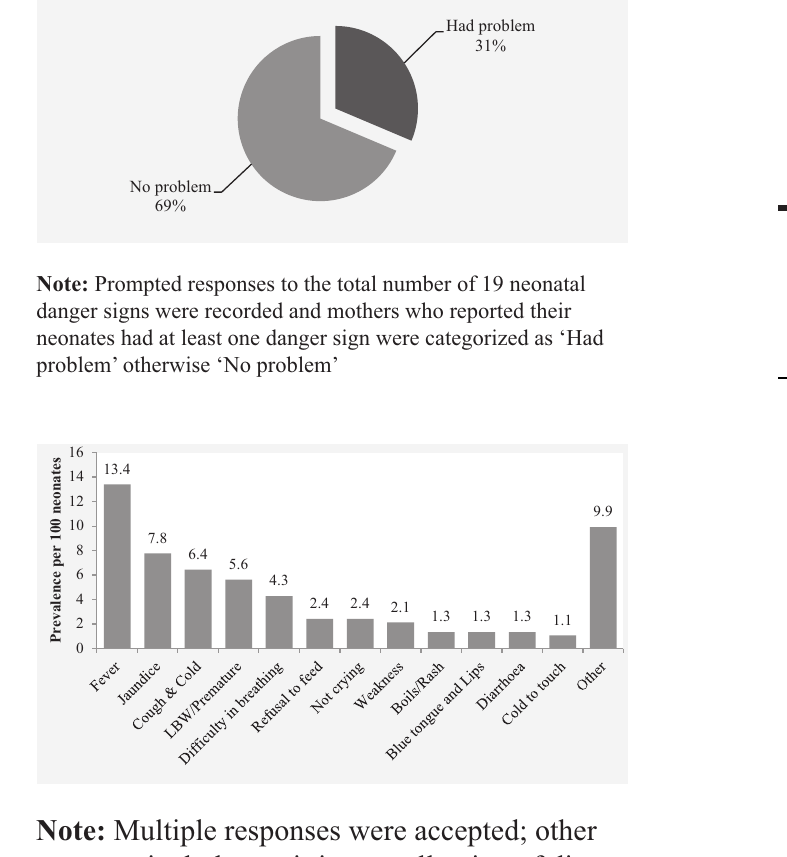
Figure 3. Patterns of reported neonatal morbidity in